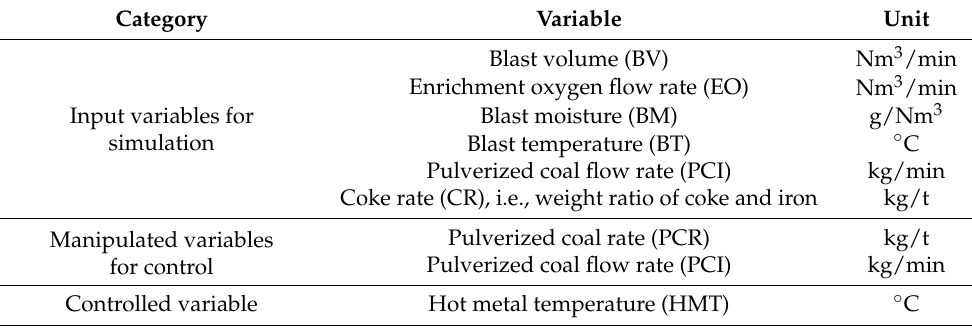
Table 1. Classification of variables in this work.